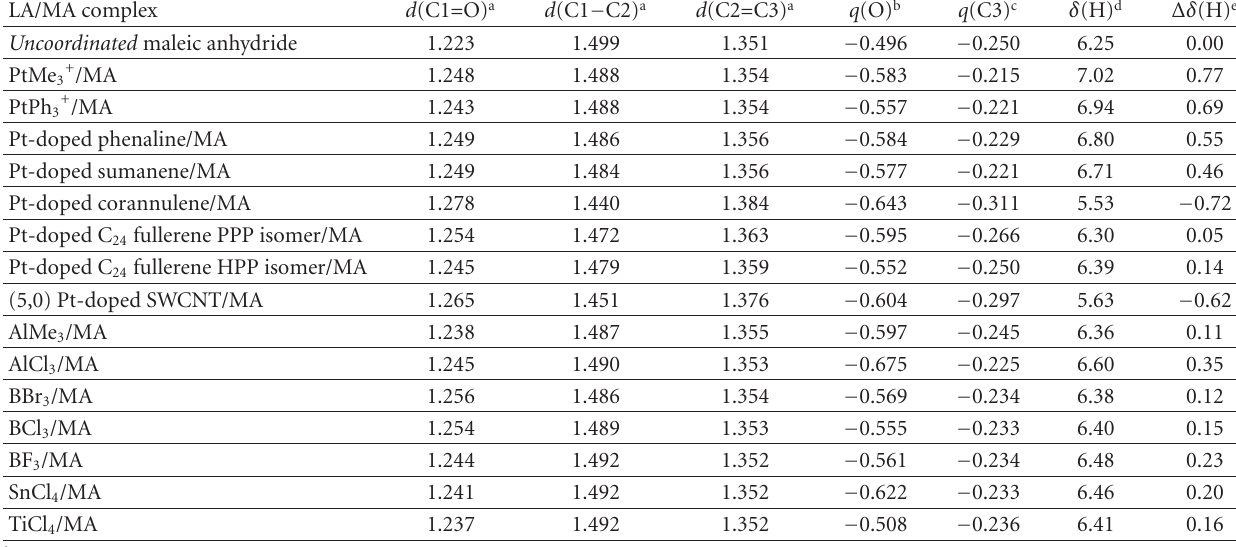
Table 7: Electronic structural data for Lewis acid/maleic anhydride complexes